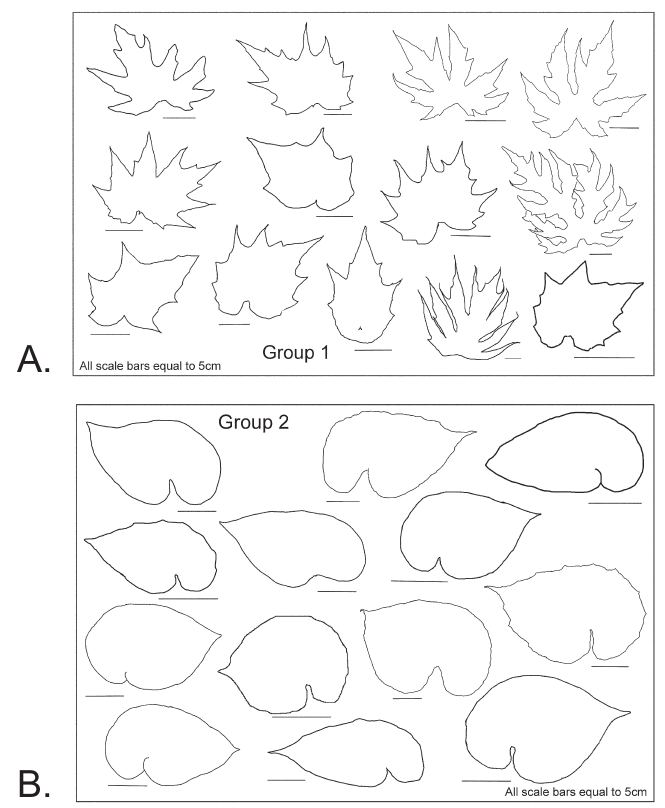
Fig. 2. Leaf tracings. A . Group 1: scalloped, lobed or incised leaves. B . Group 2: ovate, asymmetric, and entire